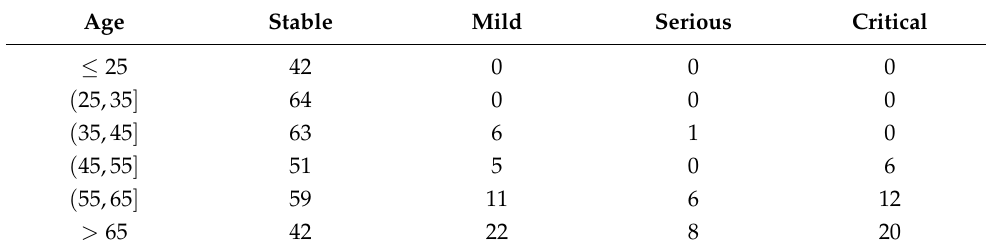
Table 5. Contingency table for exposure age to Severity of the case.